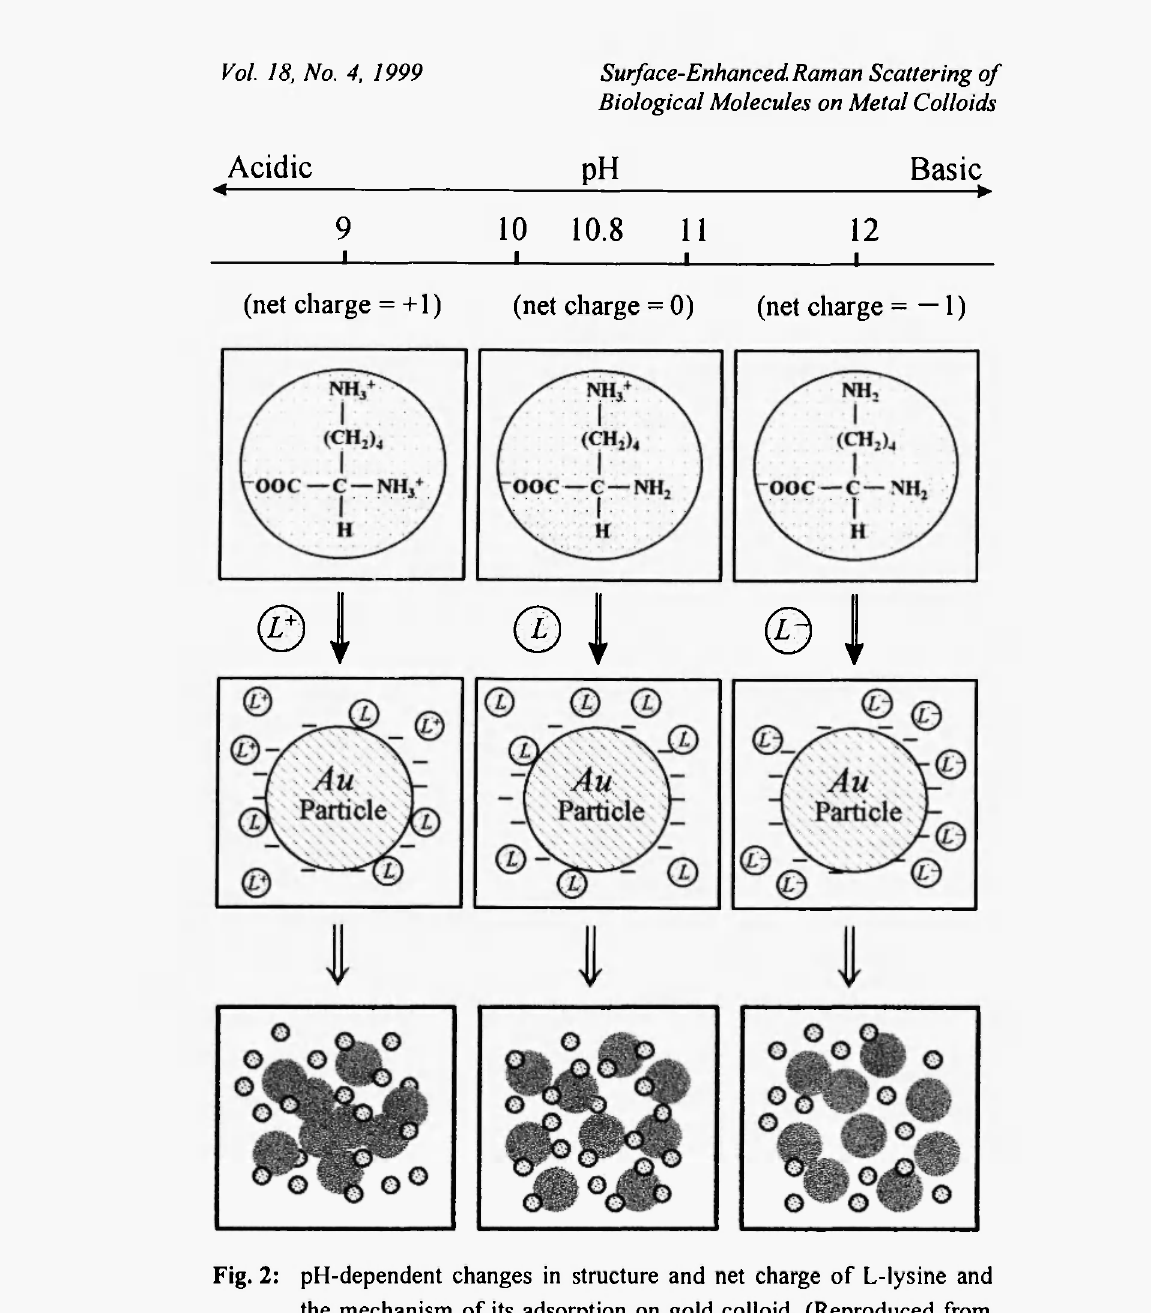
Fig. 2: pH-dependent changes in structure and net charge of L-lysine and the mechanism of its adsorption on gold colloid. (Reproduced from ref. 20 with permission. Copyright (1999) Society for Applied